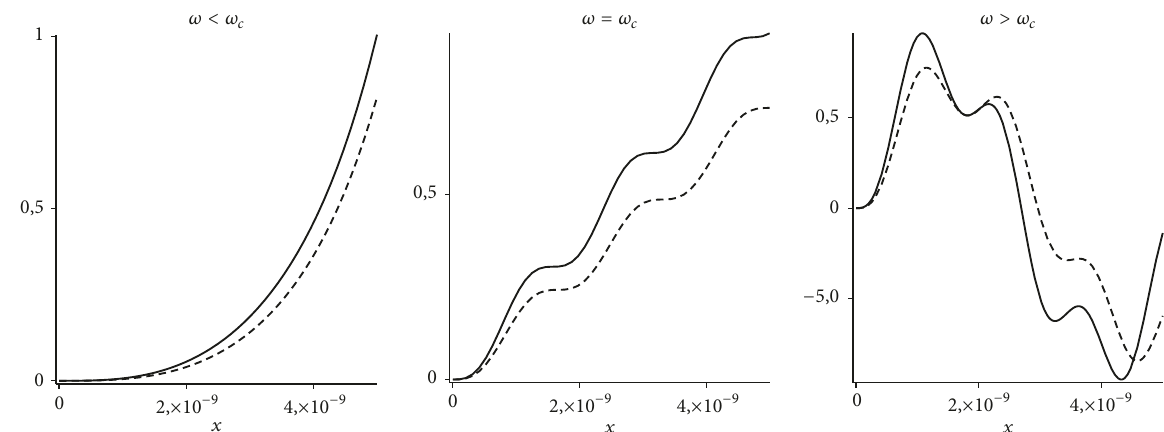
Figure 6: Behavior of the fundamental solution 𝑑(𝑥) , according to critical natural frequency 𝜔 𝑐 = √𝑎/𝑒 , using 𝐿 = 5 × 10 −9 and 𝐴𝑙[111] beam configuration, including surface effects (dashed line) and classical case (solid line).